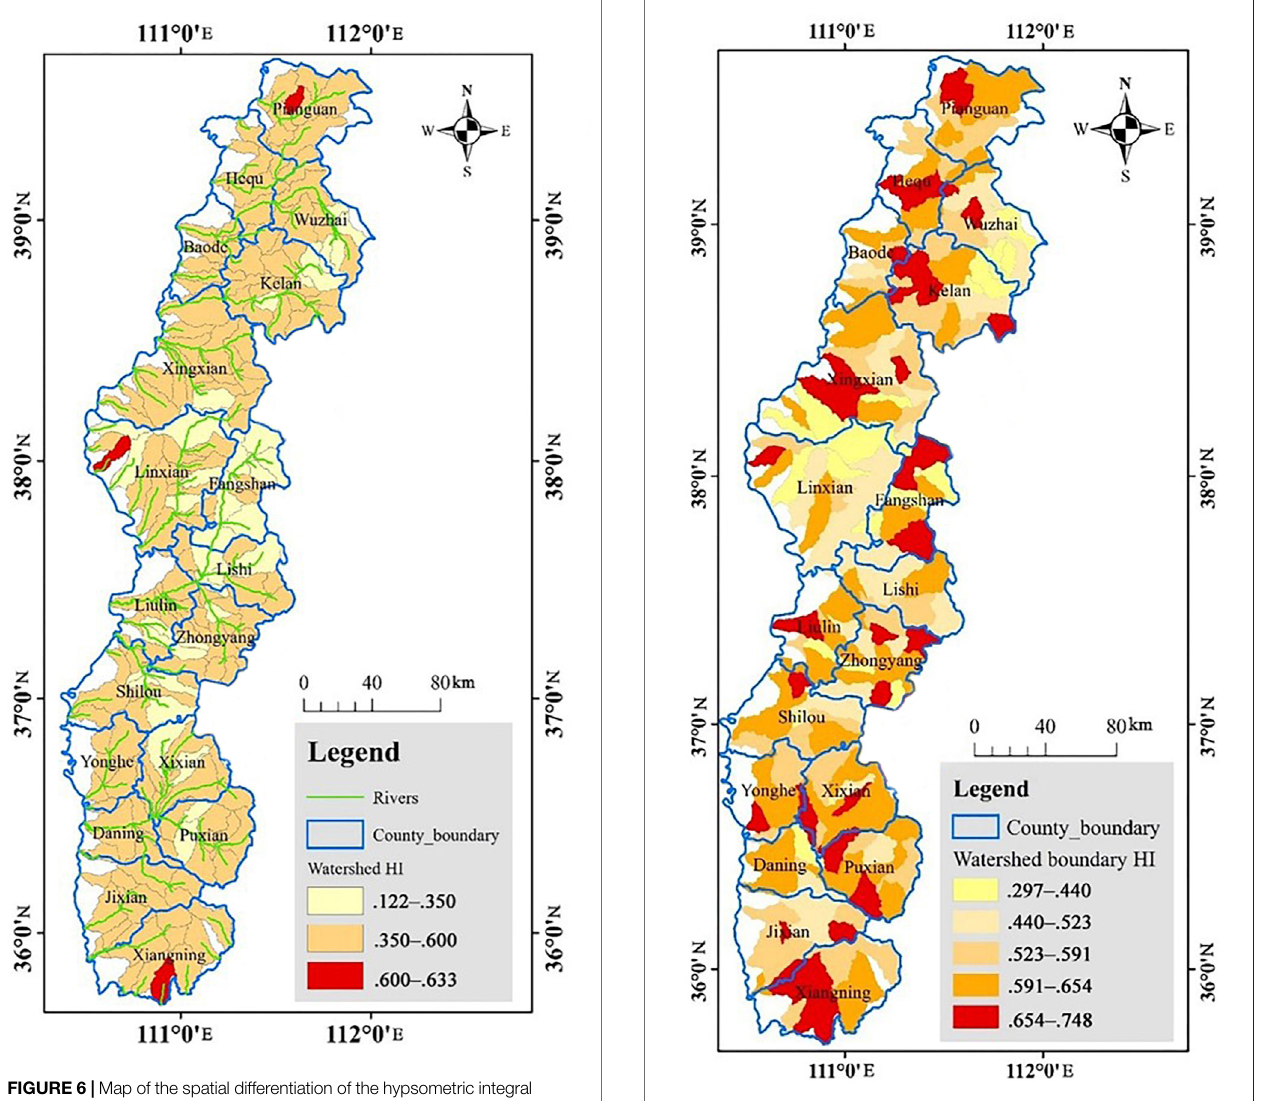
Frontiers in Earth Science |